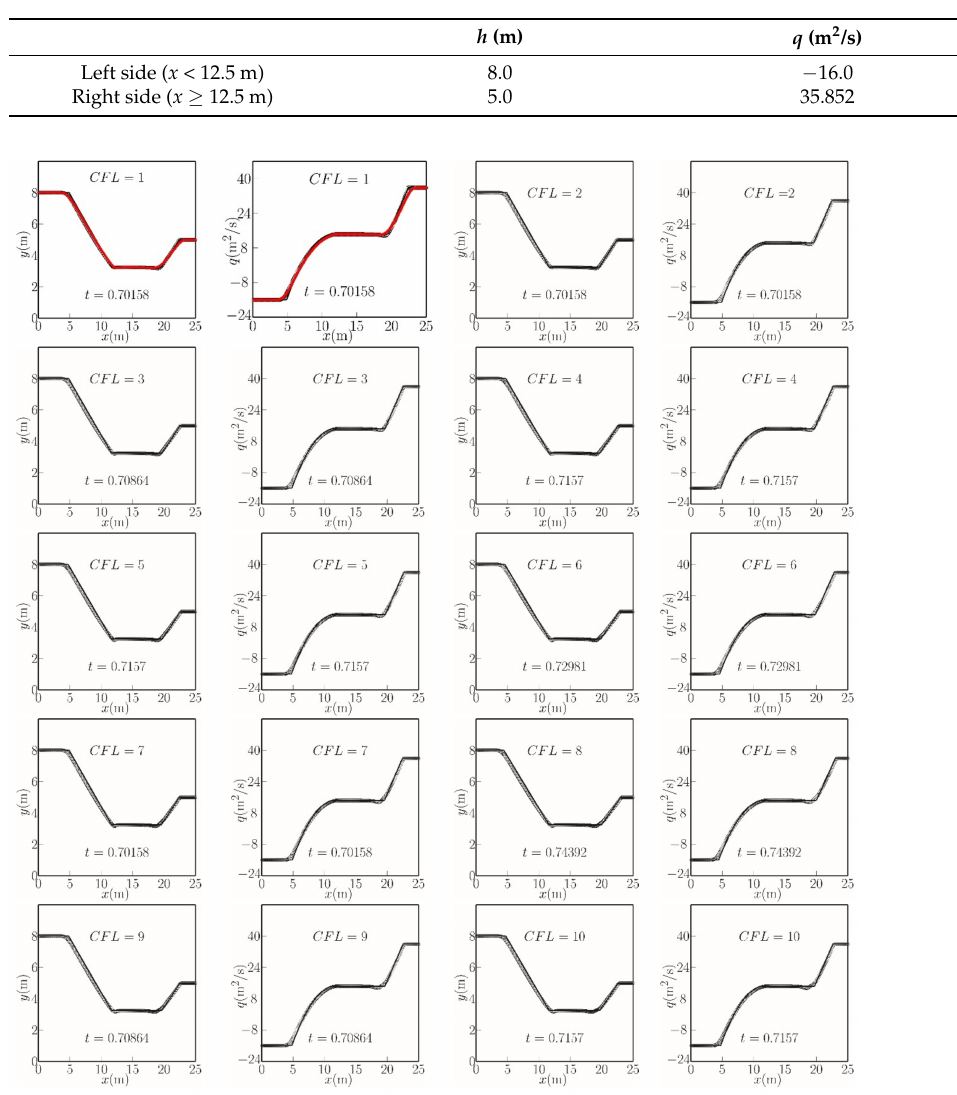
Table 1. Initial conditions for a homogeneous case of two rarefaction waves in a frictionless, horizontal channel.